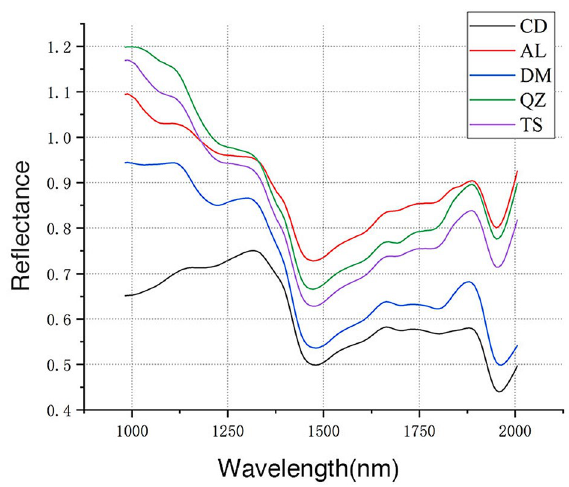
Figure 2. Mean spectra for the radial section of samples. CD = G. conjugate ; AL = G. ehie ; DM = G. demeusei ; QZ = G. coleosperma ; TS = G. tessmannii .